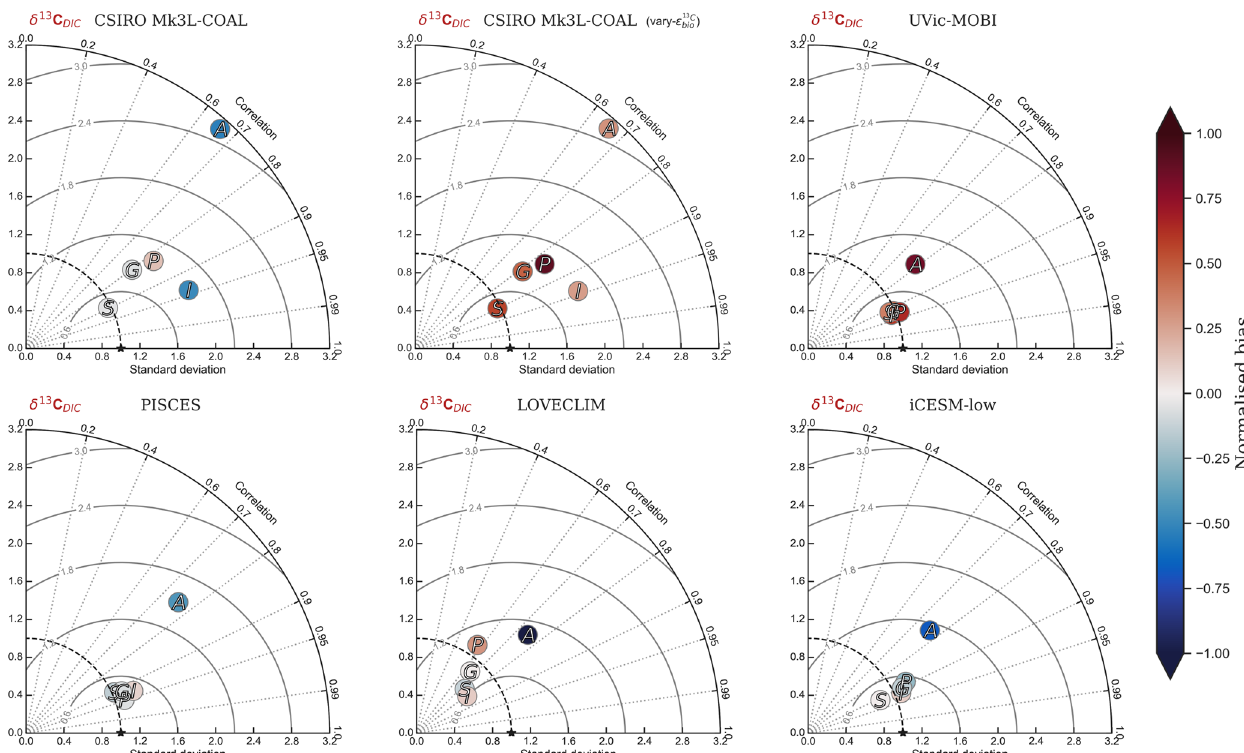
Figure 2. Global and regional fits between data (Eide et al., 2017) and simulated δ 13 C of dissolved inorganic carbon displayed as Taylor diagrams (Taylor, 2001). Shading of the markers represents normalised bias. G indicates global; S indicates Southern Ocean (90–40 ◦ S); A indicates Atlantic (40 ◦ S–70 ◦ N); P indicates Pacific (40 ◦ S–70 ◦ N); I indicates Indian Ocean (40 ◦ S–70 ◦ N). Measures of fit do not include the Arctic or the upper 200m of the water column. All data were regridded onto the CSIRO Mk3L-COAL grid space before comparison.